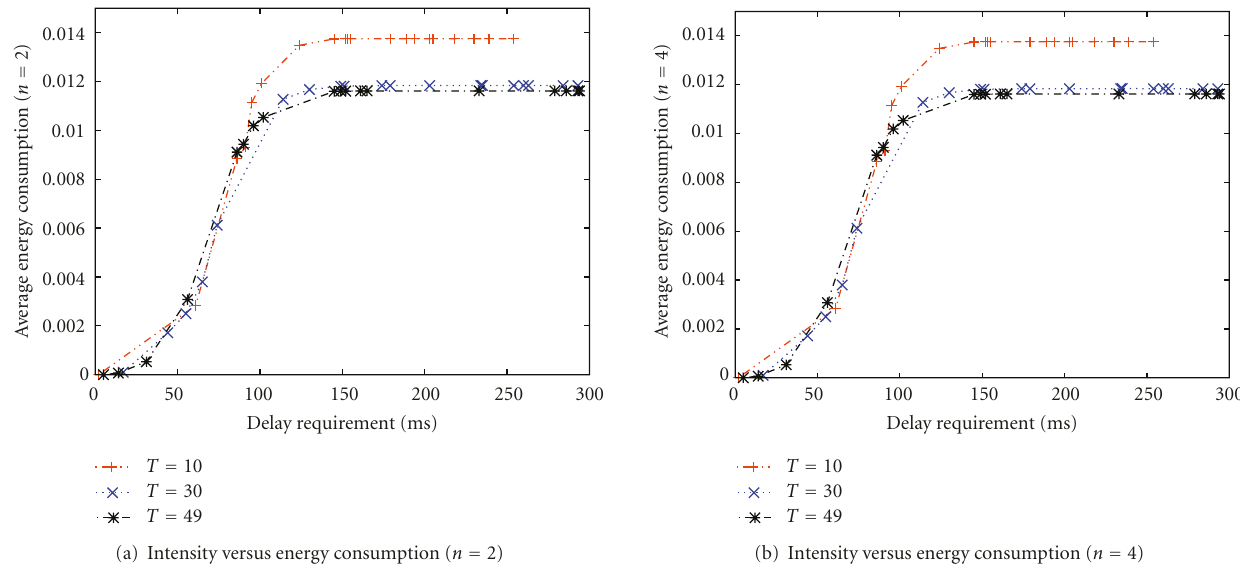
Figure 10: The impact of sensing intensity on